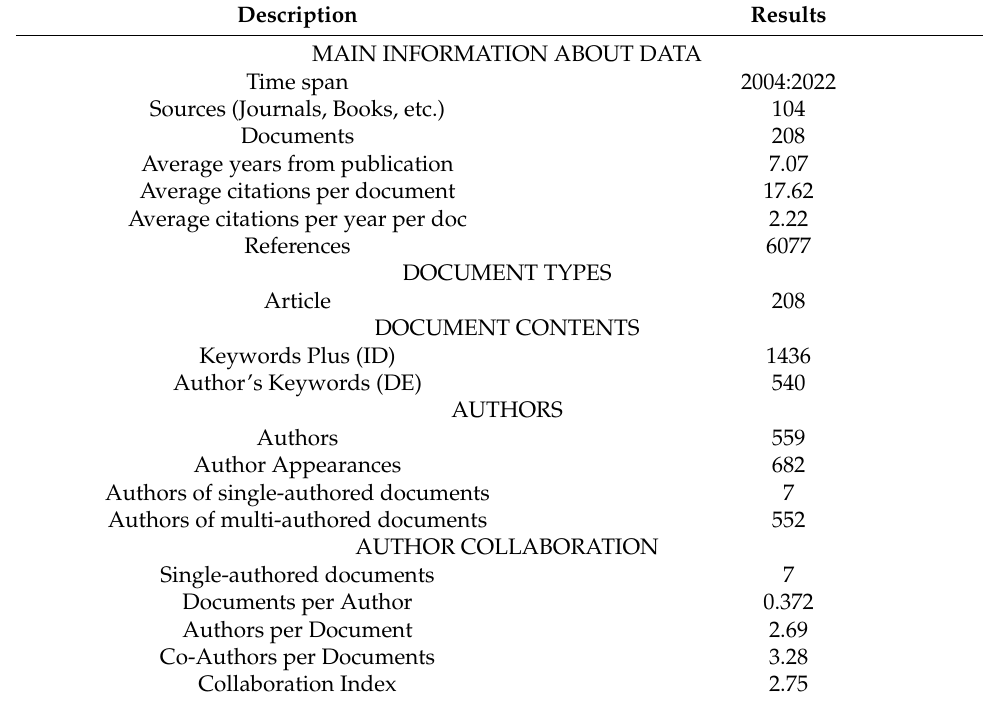
Table 1. The Main Information Needed to Perform Scientometric Analysis.